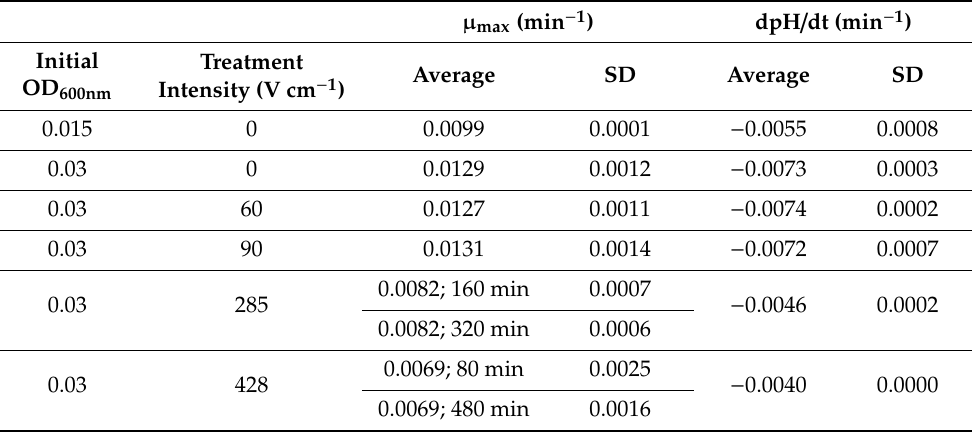
Figure 3. Growth and acidification kinetics of L. delbrueckii subsp. bulgaricus CFL1 in MRS broth with a medium circulation flow rate of 25 ± 2 mL min − 1 . □ ► ◄ ● , fermentations performed with the initial OD 600nm of 0.03 without PEF treatment, with PEF treatment at voltages of 60, 90, 285, 428 V cm − 1 , respectively. ◊ , fermentation performed with less inoculum giving an initial OD 600nm of 0.015 without PEF treatment. ( A ) Absorbance (AU) of medium determined using the biomass probe, ( B ) specific growth rate µ , ( C ) pH values of medium, ( D ) acidification rate dpH / dt. Vertical error bars represent the standard deviation of three biological replicates. Table 1. Impact of PEF treatment on the growth and acidification